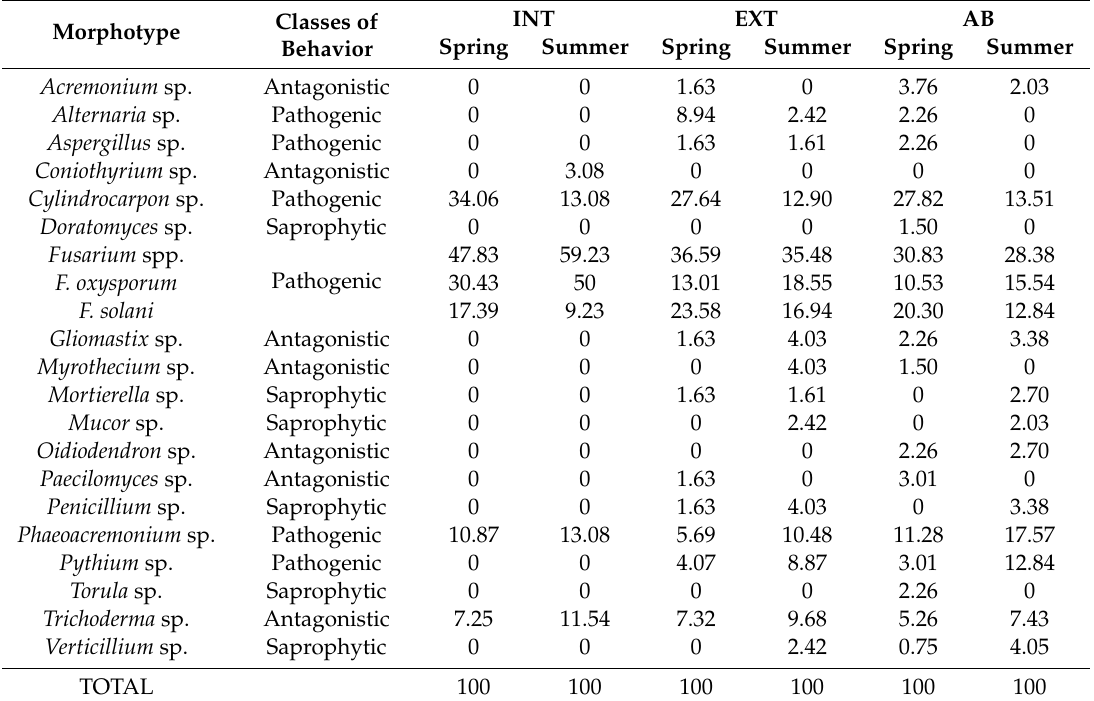
Table 3. Percentage (%) of frequency of fungal morphotypes isolated from the surface of vine-roots, grouped by the examined vineyard management methods and seasons.